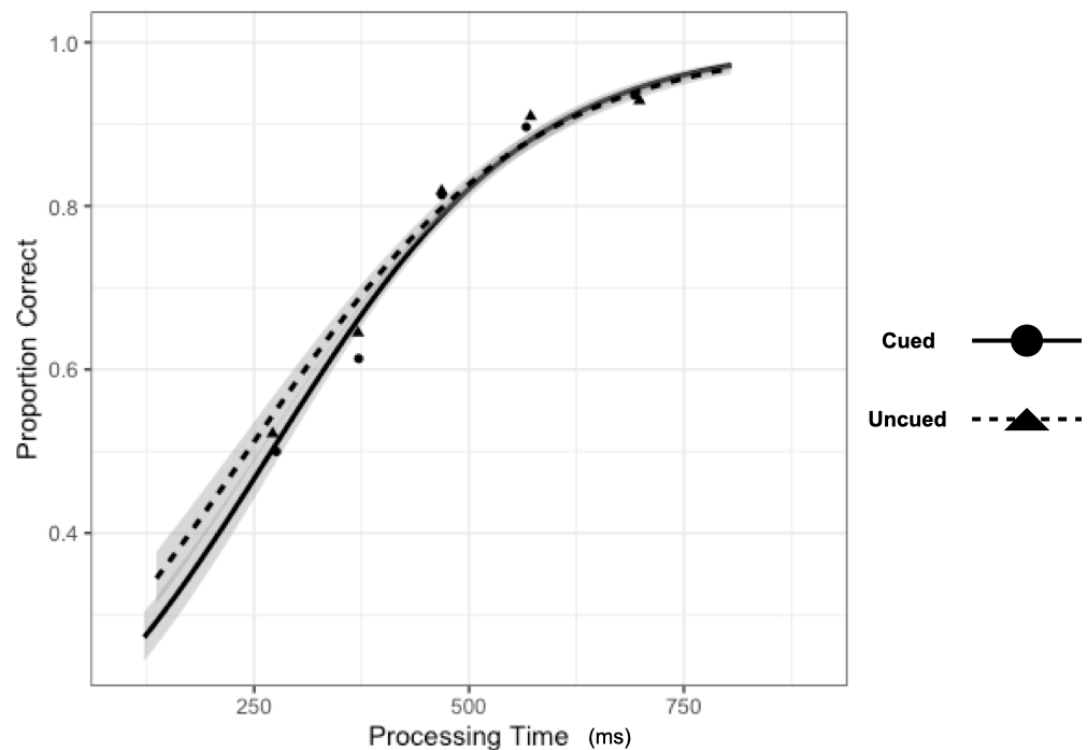
Figure 7. Information processing functions for cued (solid; circles) and uncued (dashed; triangles) performance. Processing time was calculated as the sum of the mean tone RT within a TTOA plus the TTOA. Grey shaded area reflects the 95% confidence interval for the fit of each cueing condition. Points represent the mean Processing Time and Proportion Correct for each Cueing condition for each of the five TTOAs.